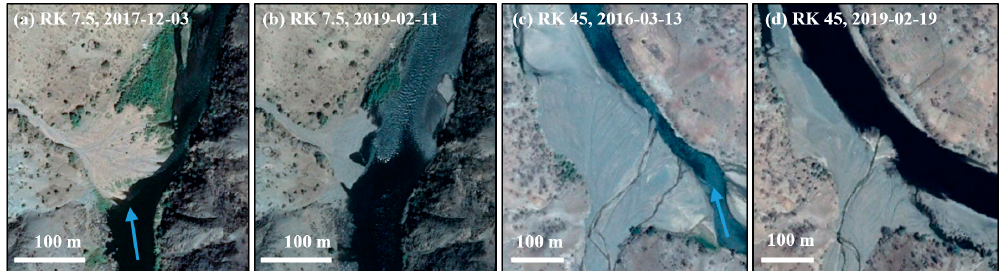
Figure 12. Examples of large alluvial cones that were (partially) eroded during the 2018 emergency release, after they had been gradually expanding for several years. Although discharges vary slightly on the photos, it does not impact the observed results: ( a ) 85 m 3 s − 1 vs. ( b ) 127 m 3 s − 1 and ( c ) 29 m 3 s − 1 vs. ( d ) 126 m 3 s − 1 (Data source: [39], Google Earth).